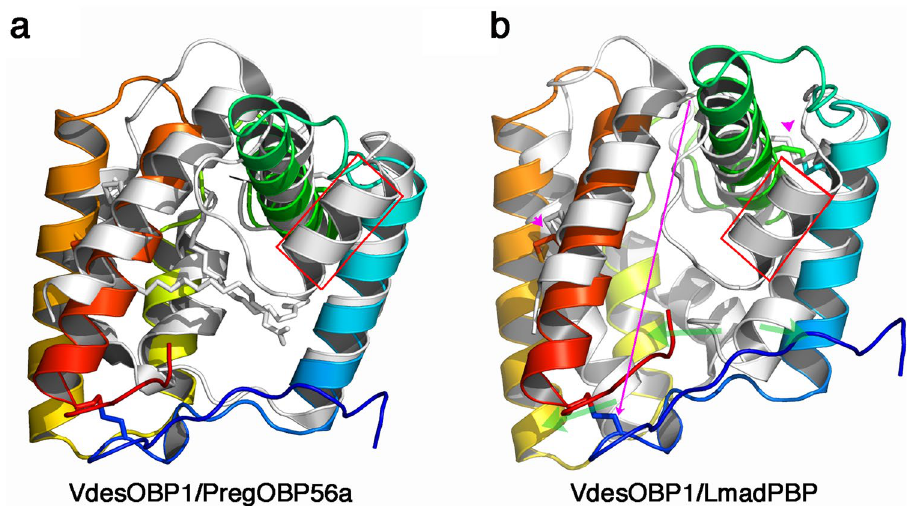
Figure 7. Comparison of crystal structures of VdesOBP1 with the closest related OBPs from Phormia regina (PregOBP56) and Leucophera madereae (LmadPBP). ( a ) Ribbon view of the superposition of monomers from VdesOBP1 (rainbow coloured) and PregOBP56 (light grey) with its two fatty acid ligands (grey sticks). Note the absence of the classical OBP fold helix 2 (red squared) in VdesOBP1. ( b ) Ribbon view of the superposition of monomers from VdesOBP1 (rainbow coloured) and LmadPBP. Note the absence of the classical OBP fold helix 2 (red squared) in VdesOBP1 as compared to LmadPBP (red squared) and the shift of one disulphide bridge (red arrow). The 3D positions of the two other disulphide bridges are conserved (purple arrow), in the final fold, although as result of different C1-C6, C2-C3, C4-C5 (VdesOBP1) and C1-C3, C2-C5, C4-C6 (LmadPBP) connectivities. Figure made with PyMOL (version 1.5.0.2. http:// www. pymol.